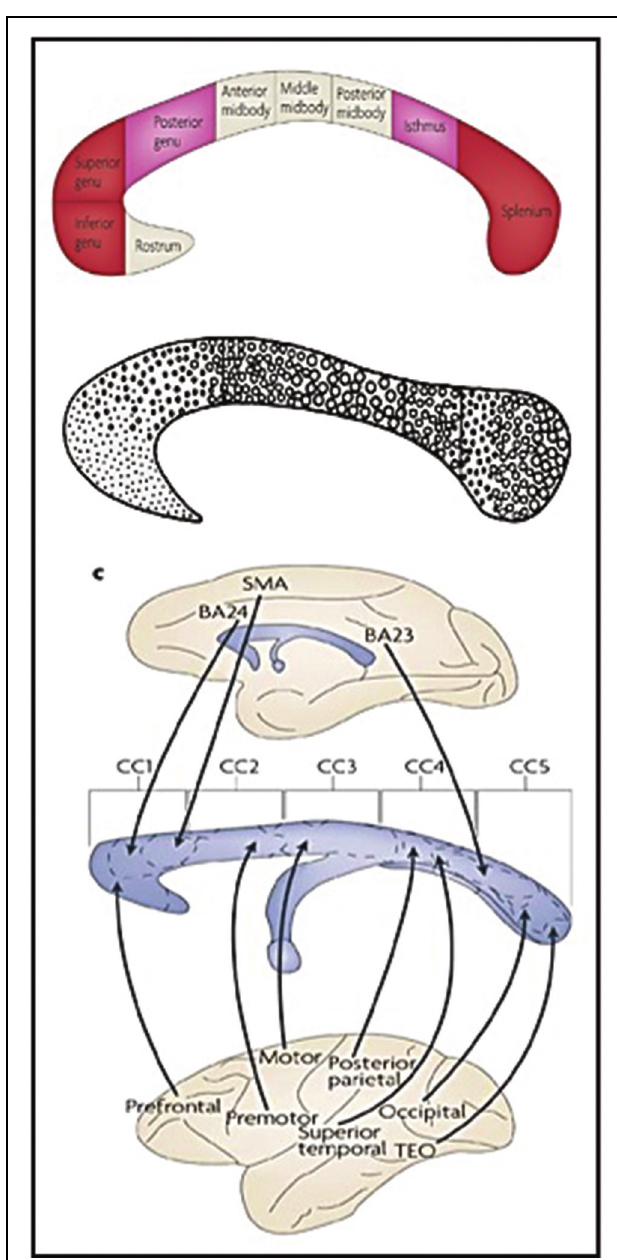
FIGURE 2 | The structure of the Corpus Callosum permits interhemispheric connectivity in the posterior cortex. (Composition of pictures modified from: Aboitiz et al., 2003; Paul et al., 2007; Uhlhaas and Singer, 2010b.)